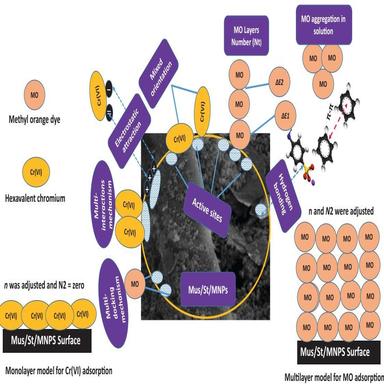
Proposed mechanism for the adsorption of Cr(VI) and MO on Mus/St/MNPs.